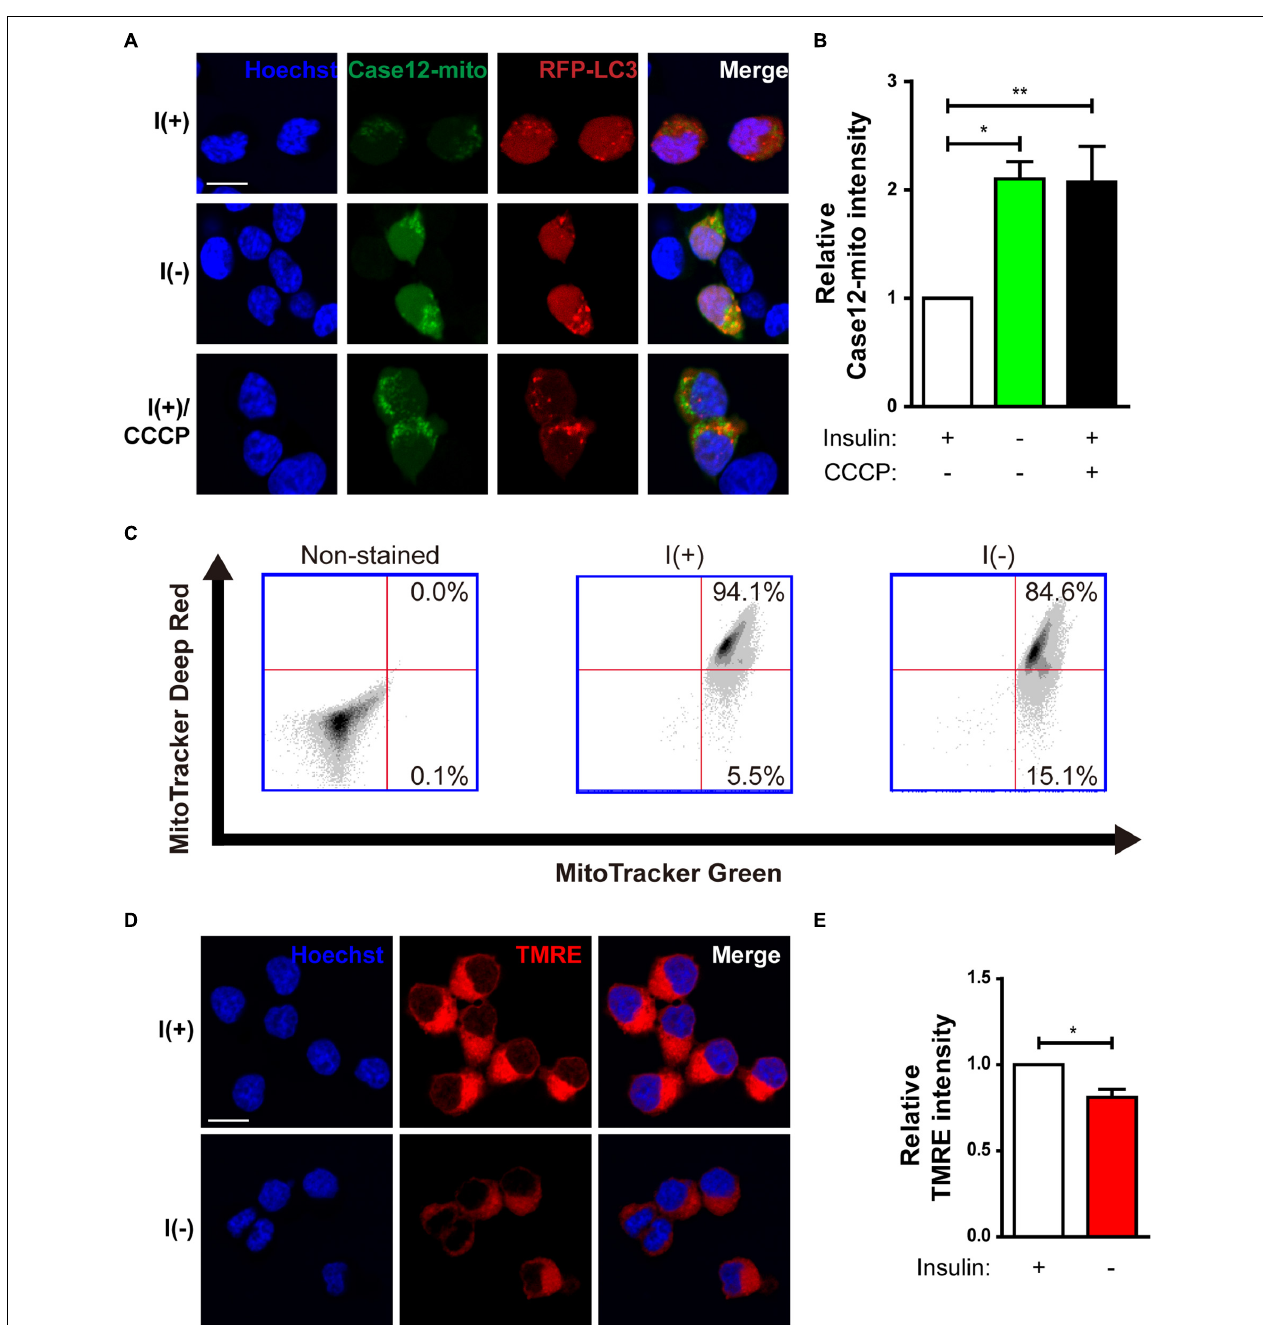
FIGURE 2 | Changes in mitochondria of HCN cells after insulin withdrawal. (A) Assessment of mitochondrial Ca 2 + levels using Case12-mito after insulin withdrawal for 24 h. Scale bar, 10 µ m. (B) Quantification of fluorescence intensity of Case12-mito in HCN cells ( n = 33 cells for I( + ), 25 cells for I(-), 36 cells for I( + )/CCCP from 3 independent experiments). (C) FACS analysis of HCN cells stained with MitoTracker Green to determine the total number of mitochondria and MitoTracker Deep Red to determine the number of depolarized mitochondria after insulin withdrawal for 24 h. 30,000 cells were analyzed in each experiment. (D) Fluorescence imaging analysis of TMRE-stained HCN cells. Scale bar, 10 µ m. (E) Quantification of fluorescence intensity of TMRE in HCN cells ( n = 12 cells from 2 independent experiments). Relative TMRE intensity of fluorescence microscope image was measured by image J. ∗ p < 0.05, ∗∗ p < 0.01.